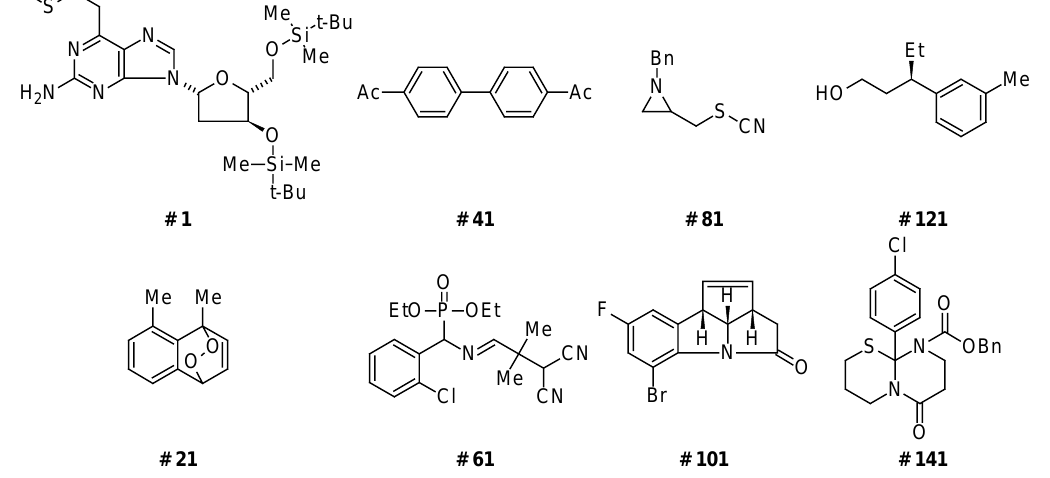
Figure 1 . Every 20 th structure of the data set with the corresponding